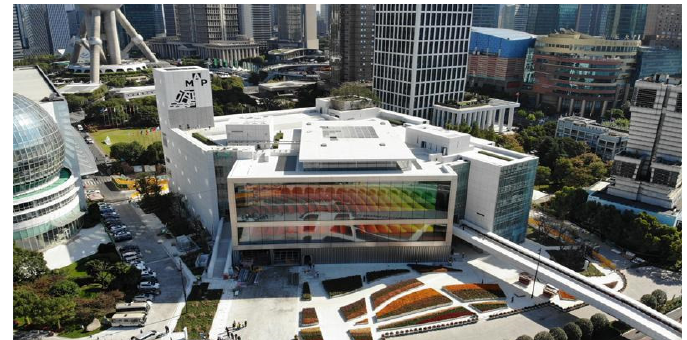
Figure 9. The Jean Nouvel-designed Museum of Art Pudong launched in 2021 with a partner exhibition from Britain’s Tate, image courtesy of Rider Levet Bucknall.